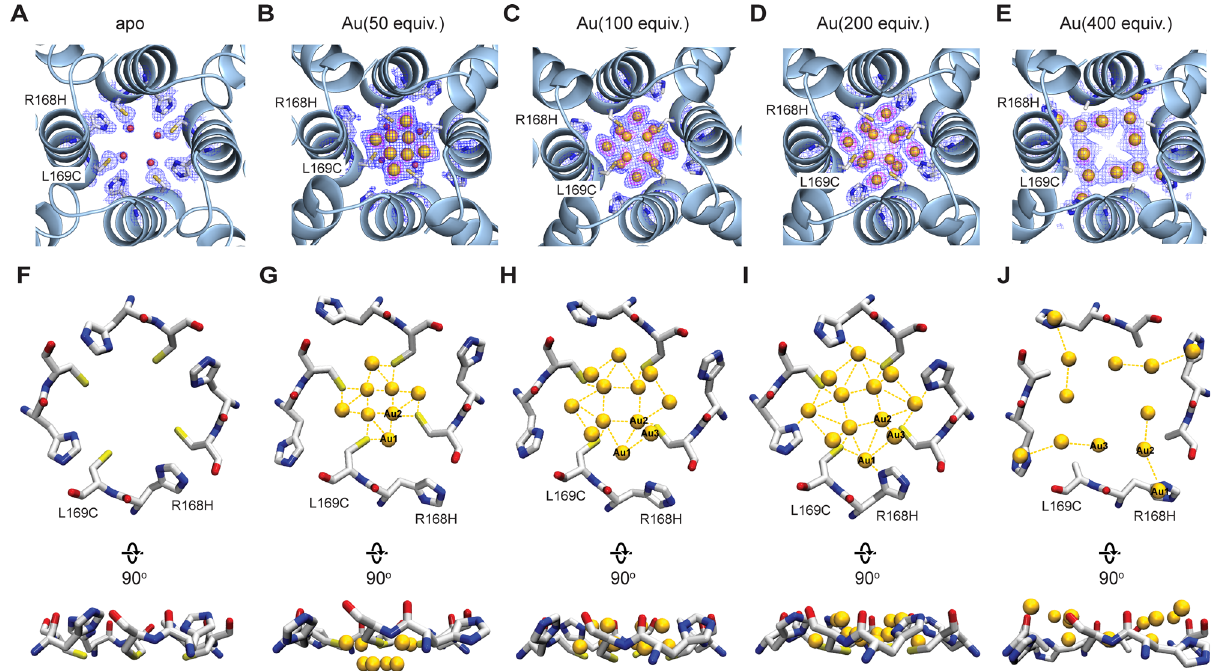
Fig. 4 X-ray crystal structures of the assigned Au clustering site at the 4-fold symmetric channel in apo-R168H/L169C-rHLFr while using various Au precursors. A – E Assigned positions of Au ions at the 4-fold axis channel of apo-R168H/L169C-rHLFr Au composites with different equiv. The selected 2Fo – Fc maps at 1 σ and anomalous difference Fourier density maps at 4 σ are shown in blue and magenta, respectively. Au(50 equiv.)-apo-R168H/L169C- rHLFr ( A ); Au(100 equiv.)-apo-R168H/L169C-rHLFr ( B ); Au(200 equiv.)-apo-R168H/L169C-rHLFr ( C ); Au(400 equiv.)-apo-R168H/L169C-rHLFr ( D ). F – J The coordination structure of each Au at the 4-fold axis channel of apo-R168H/L169C-rHLFr Au composites with different equivalents. apo-R168H/L169C- rHLFr ( F ); Au(50 equiv.)-apo-R168H/L169C-rHLFr ( G ); Au(100 equiv.)-apo-R168H/L169C-rHLFr ( H ); Au(200 equiv.)-apo-R168H/L169C-rHLFr ( I ); Au(400 equiv.)-apo-R168H/L169C-rHLFr ( J ). Figures were made in PyMol.